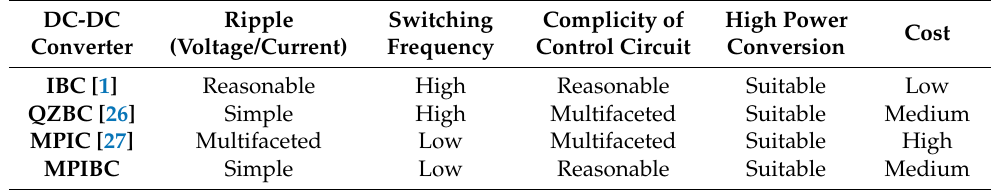
Table 1. MPIBC comparison with other converters.